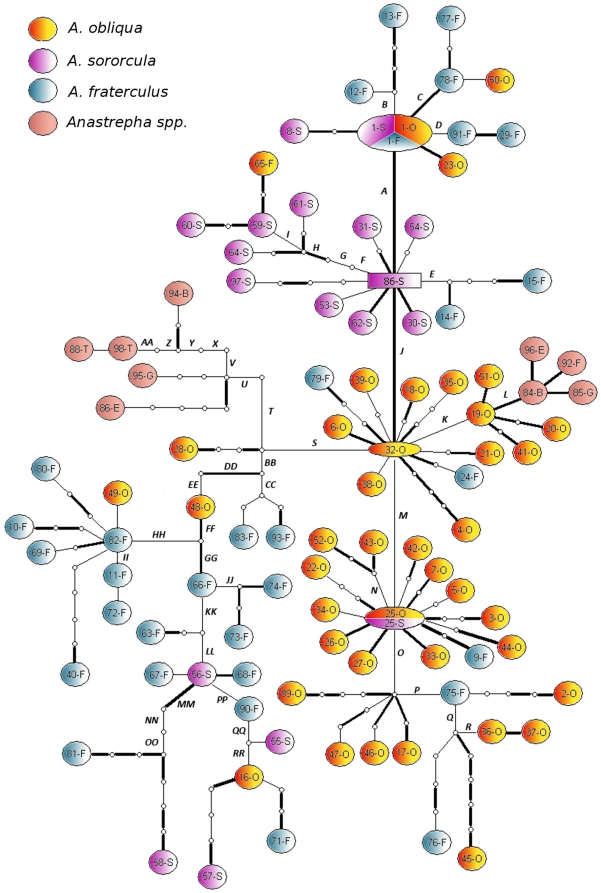
Haplotype network estimated by statistical parsimony (TCS ver 1.21).Thicker lines represent nonsynonymous substitutions and small circles stand for inferred haplotypes. Haplotypes were labeled sequentially and the subsequent letters represent the respective identified species. O – A. obliqua, F – A. fraterculus, S – A. sororcula, G – A. grandis, T – A. striata, B – A. bistrigata, E– A. serpentina. Letters near lines represent internal mutations labels.